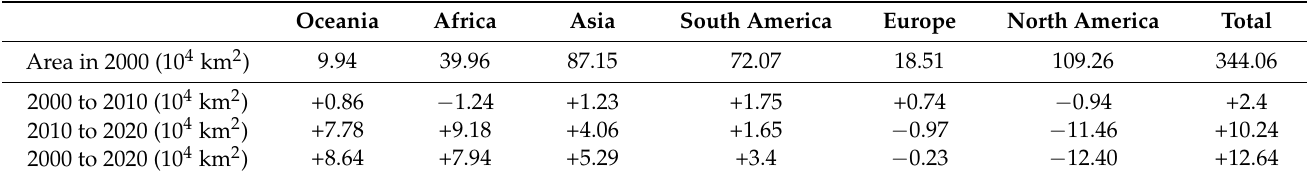
Table 1. Changes in wetland areas by continent from 2000 to 2020.